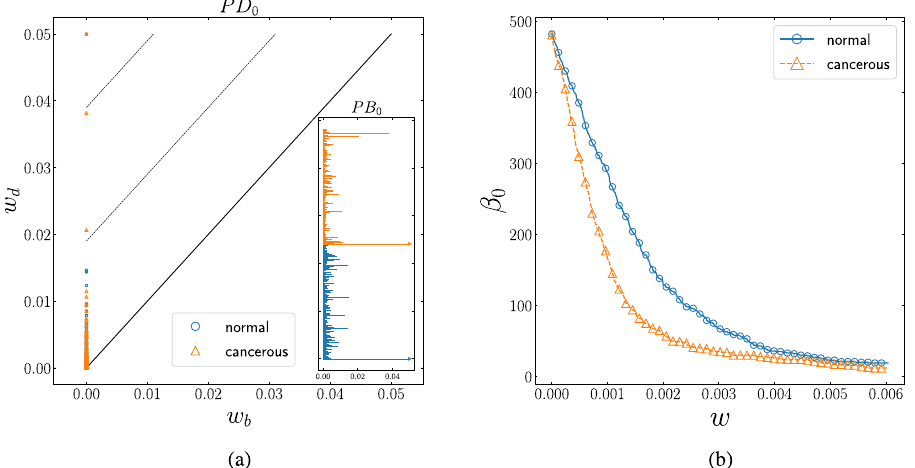
Figure 3. (a) Persistence diagram of 0-homology group ( PD 0 ) for the normal (blue circles) and the cancer (orange triangles) gene interaction network. The cancerous network includes two small persistent clusters (orange triangles between dashed-lines). Inset: Corresponding persistence barcode ( PB 0 ) for normal (blue bars) and cancerous (orange bars) network. The number of survived connected component (arrows) indicate that both networks are path-connected, and two orange long bars correspond to the small persistent clusters in cancerous network. (b) The number of connected components as a function of threshold ( β 0 -curve) for the normal (blue circle) and the cancer (orange triangle) network. This curves indicate that the cancer network has more global accessibility rather than the normal network. The number of connected components in the cancer data-set dropped at a smaller value.